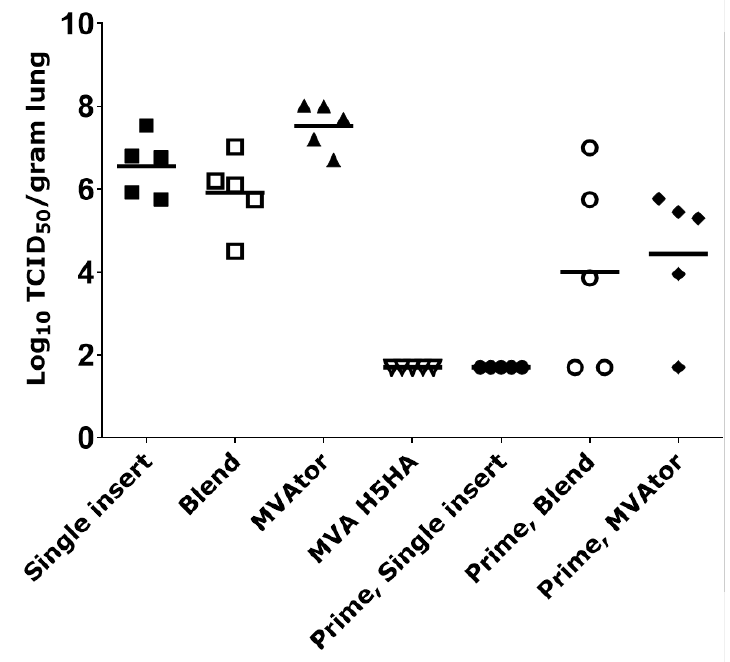
Figure 5. Lung viral burdens after immunization and H5N1 challenge. Mice were immunized two times using a single MVA vaccine that encoded M1 + NP + METRC (“single insert”) or a combination of three separate MVA vaccines each encoding M1 or NP or METRC (“Blend”). “Prime” indicates previous mild infection with PR8 H1N1 INFV A, 21 days prior to vaccine administration. A TCID 50 assay was performed to quantify infectious H5N1 virus in lungs ( N = 5 per group) 4 days after A/VN/1203/04 challenge (H5N1). The horizontal bar for each group represents the arithmetic mean Log 10 TCID 50 per gram tissue. Individual dots represent the results of each animal. The limit of detection for this assay was 1.7 Log 10 TCID 50 . Lung viral burden on day 2 (data not shown) had nearly identical results compared to day 4. Without PR8 priming, only the MVA H5HA vaccine was different ( p < 0.0001, ANOVA followed by Tukey–Kramer test) from the MVAtor control. If delivered after PR8 priming, MVA encoding M1 + NP + METRC as a single insert again was significantly different from MVAtor with priming ( p = 0.019). Priming gave protective advantage to all test vaccines including the MVAtor negative control. Limit of detection was log 1.7.